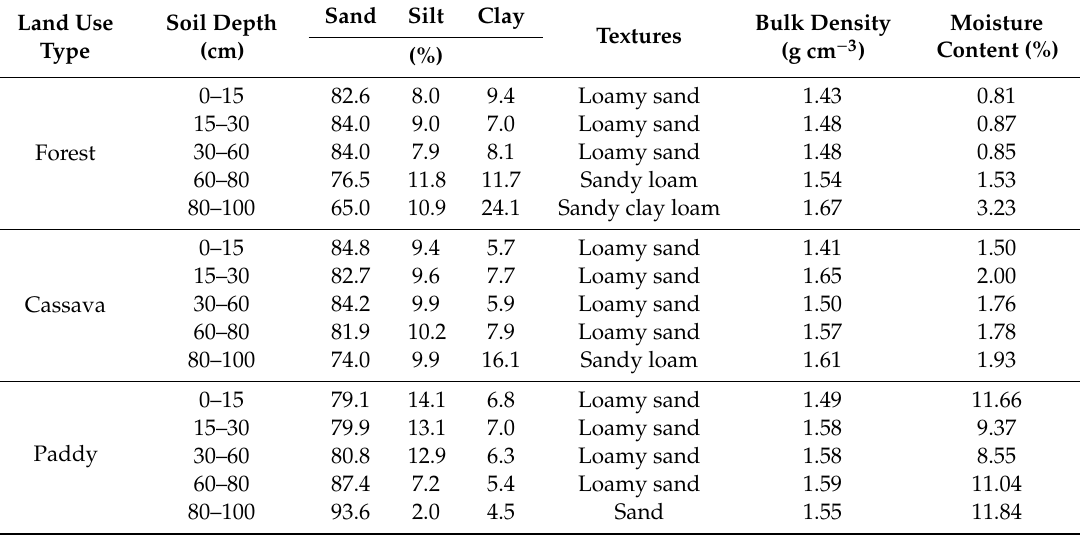
Table 1. Soil physical characteristics under di ff erent land